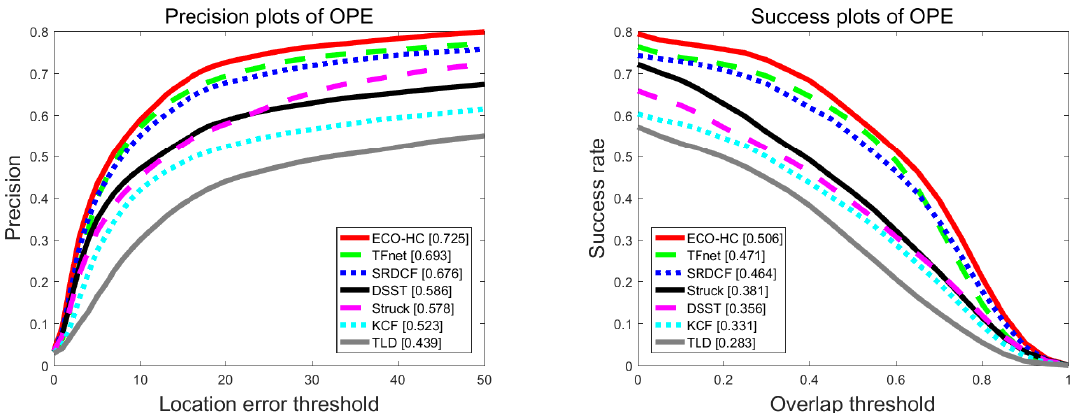
Figure 8. Distance precision plot and overlap success rates plot using one-pass evaluation on the UAV123